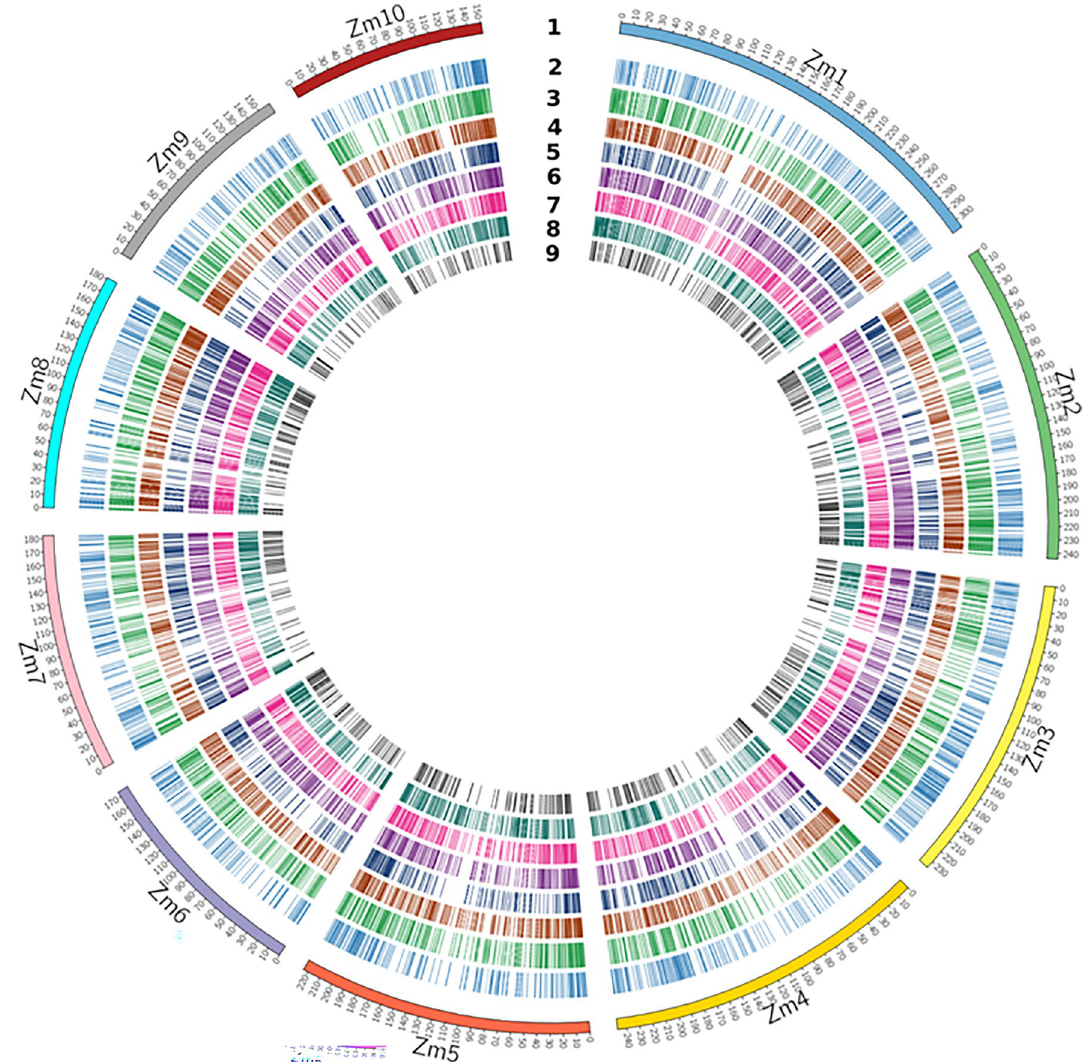
Figure 2. Circos plot depicting the distribution of DEGs on 10 chromosomes of maize. In this figure, all the maize chromosomes are displayed in the first outer ring. 2–9 numbers represents expression (log2 FC) of DEGs in various comparisons, viz., 56_RN+ vs 56_RN−, 56_RN− vs 81_RN−, 56_RN+ vs 81_RN+ , 56_SN+ vs 56_ SN−, 56_SN− vs 81_SN−, 56_SN+ vs 81_SN+, 81_RN+ vs 81_RN− and 81_SN+ vs 81_SN− respectively. Letter S, R, N+, and N− represents leaf, root, sufficient nitrogen, and nitrogen-deficiency conditions, respectively. 81 and 56 correspond to DMI 81 (N stress-susceptible genotype) and DMI 56 (N-stress tolerant genotype),